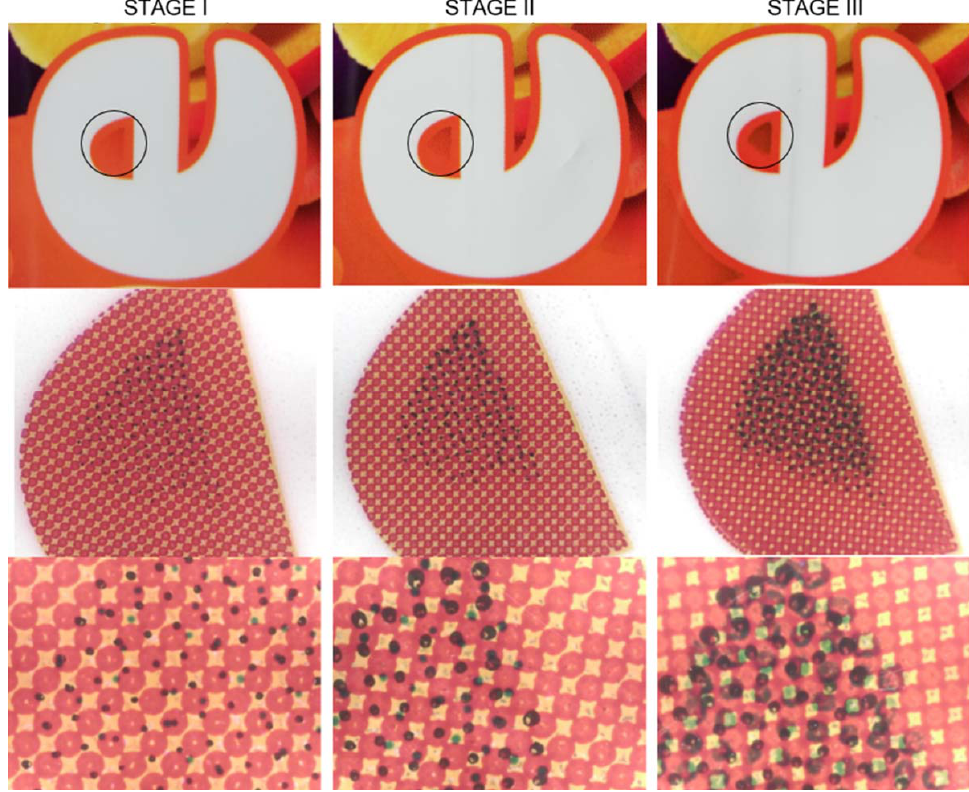
Figure 3. Appearance of dot deformations in specific stages (no. of print runs).